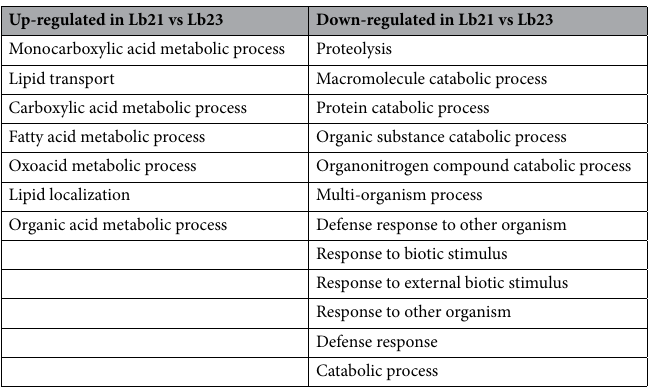
Table 1. GO enrichment analysis between Lb21 and Lb23. Full GO enrichment analysis of all groups in Lb21 compared to OP50 and P -values are listed in Table S3.